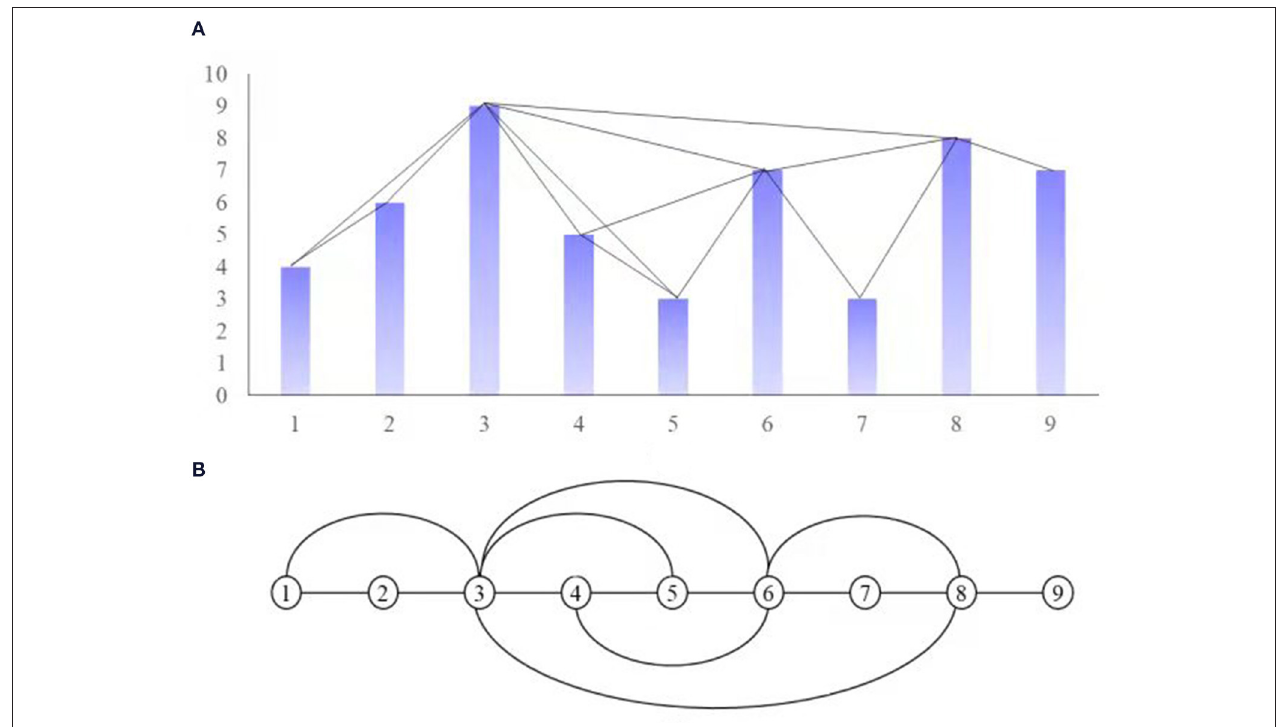
FIGURE 1 | Visiblity